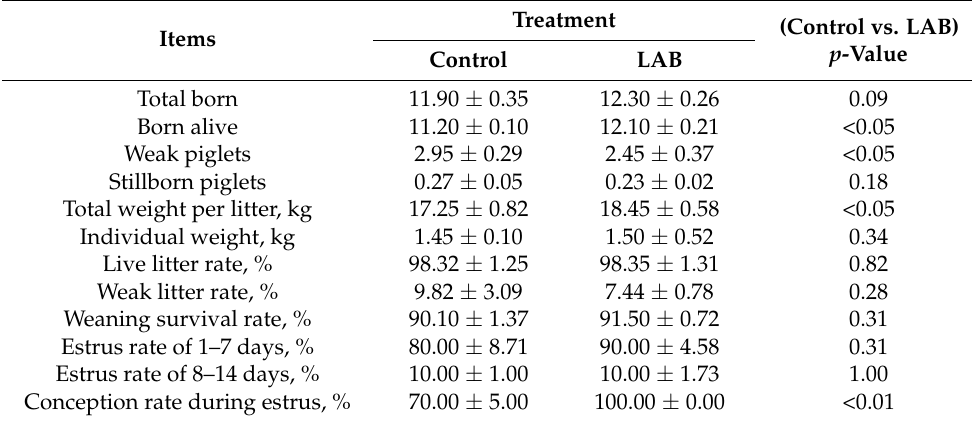
Table 6. Effects of LAB on the reproductive performance of